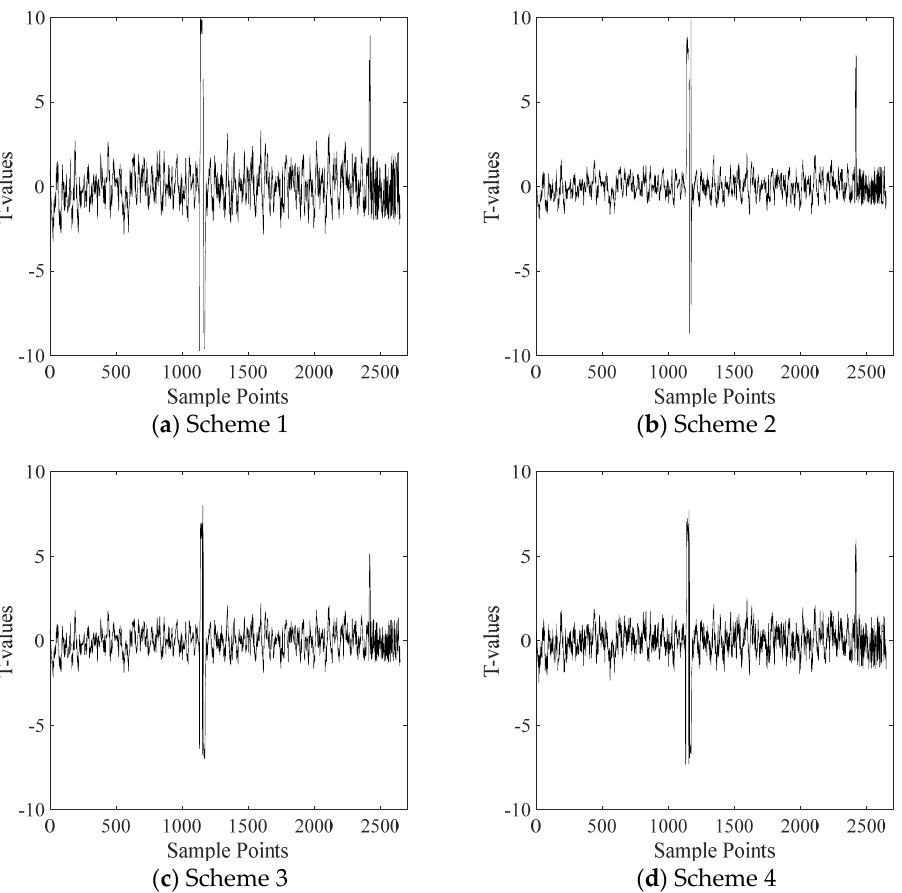
Figure 4. T--values of each scheme under a total sample size of 500. Figure 4. T-values of each scheme under a total sample size of